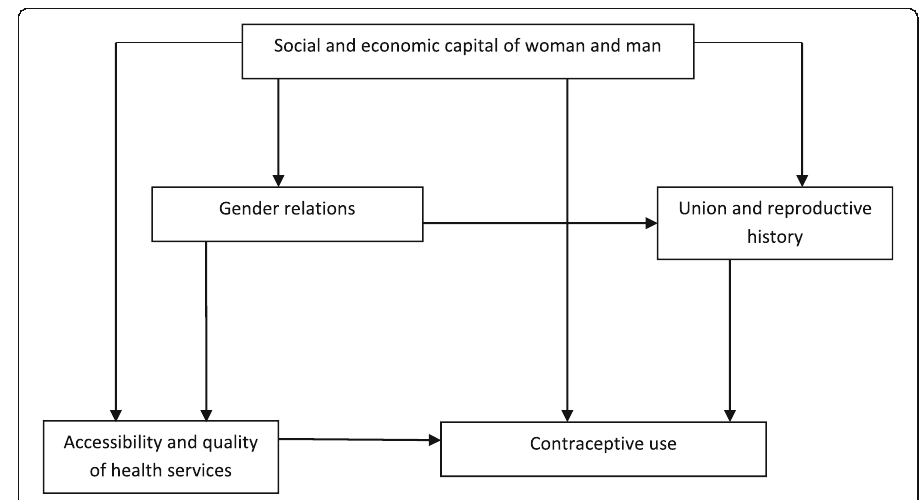
Fig. 1 A conceptual model of the determinants of contraceptive use